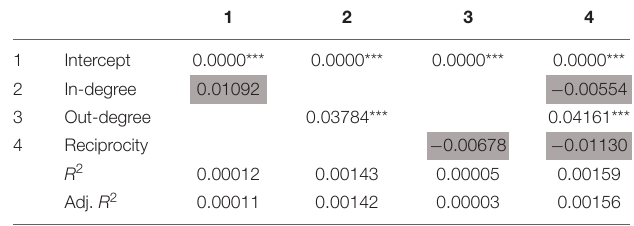
TABLE 4 | MRQAP for research question